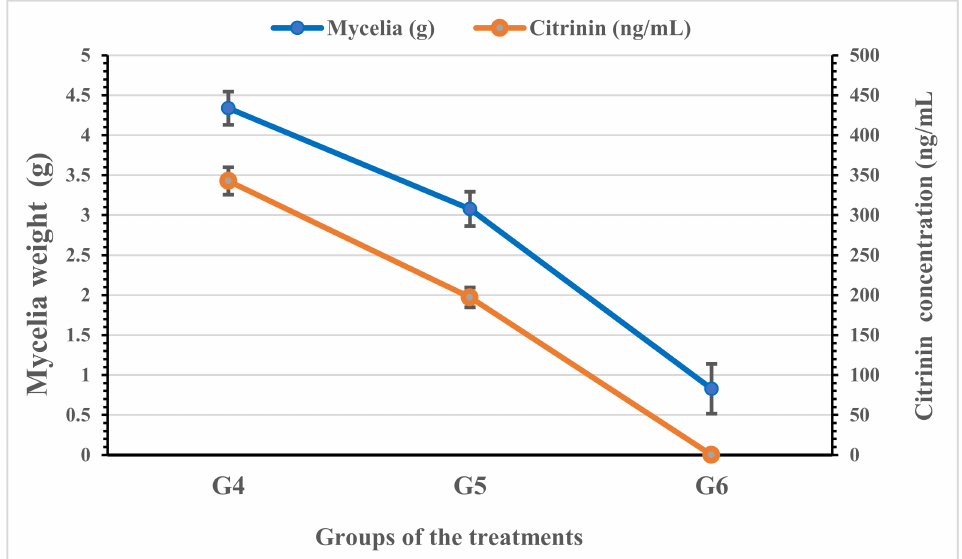
Figure 3. Anti- Penicillium properties of applied extracts (water and aromatic) in simulated media. The results are expressed as means ± SD (n = 3); WA: water extract; ArE: aromatic extract. The aromatic extract was applied in the nano-form of chitosan nanoparticles. P. chrysogenum is known to produce citrinin toxin. G4: flasks contain P. chrysogenum ; G5: flasks contain P. chrysogenum + the W.A.; G6: flasks contain P. chrysogenum + ArE.